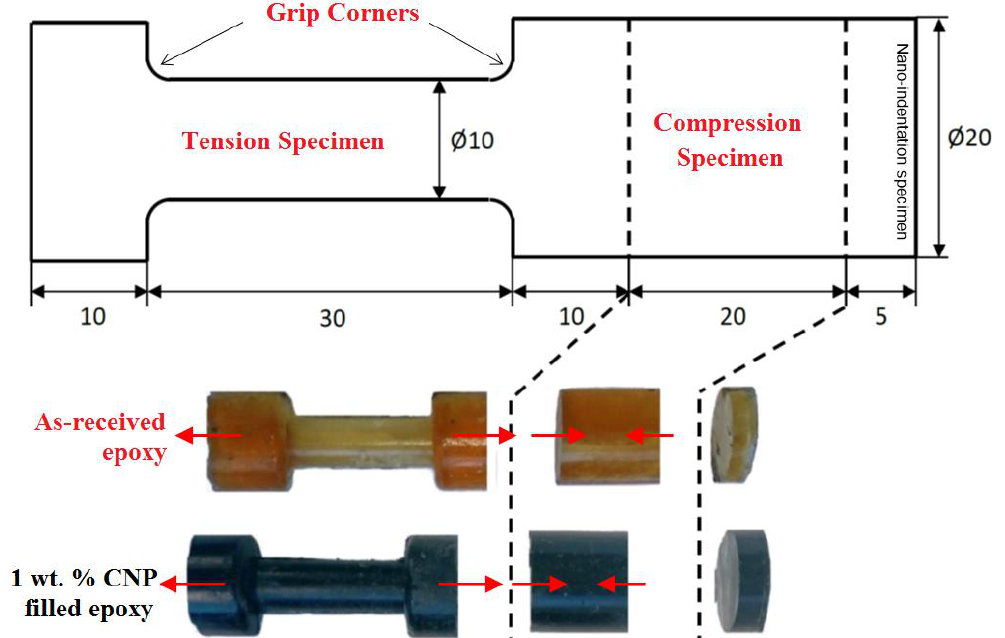
Figure 1. Cylindrical tension, compression and Nanoindentation test specimens extracted from the mold (all dimensions in mm; arrows show loading direction) from CNP filled epoxy composite.